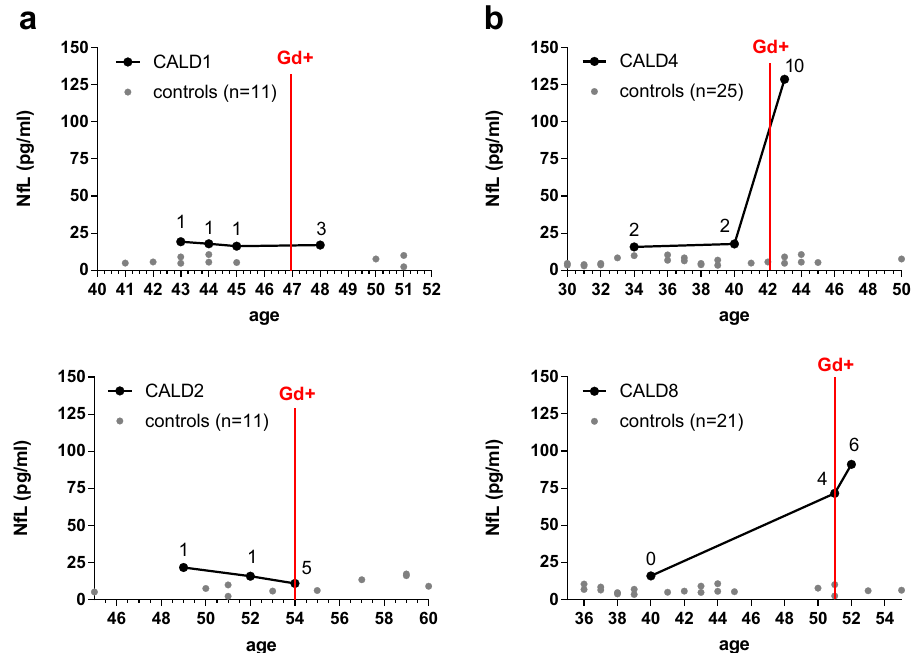
Fig. 4 Longitudinal analysis of NfL in AMN patients before and after conversion to CALD. a NfL levels up to fi ve years before and after the onset of CALD, as indicated by the presence of Gd-enhancement (Gd + , vertical red line), in two patients developing an atypical, mild, and slowly progressive adult CALD disease course (CALD1 and CALD2). b NfL levels in two AMN patients, who developed classical, rapidly progressive CALD lesions (CALD4 and CALD8), 8 – 11 years before and with the start of Gd-enhancement. Numbers above each patient ’ s data points indicate the corresponding MRI brain lesion severity Loes scores. For comparison, gray circles show NfL levels of the healthy control cohort in similar age ranges ( a ) age 41 – 51, n = 11; age 45-60, n = 11, ( b ) age 30 – 50, n = 25; age 36 – 55, n = 21. Source data are provided as a Source Data fi le.